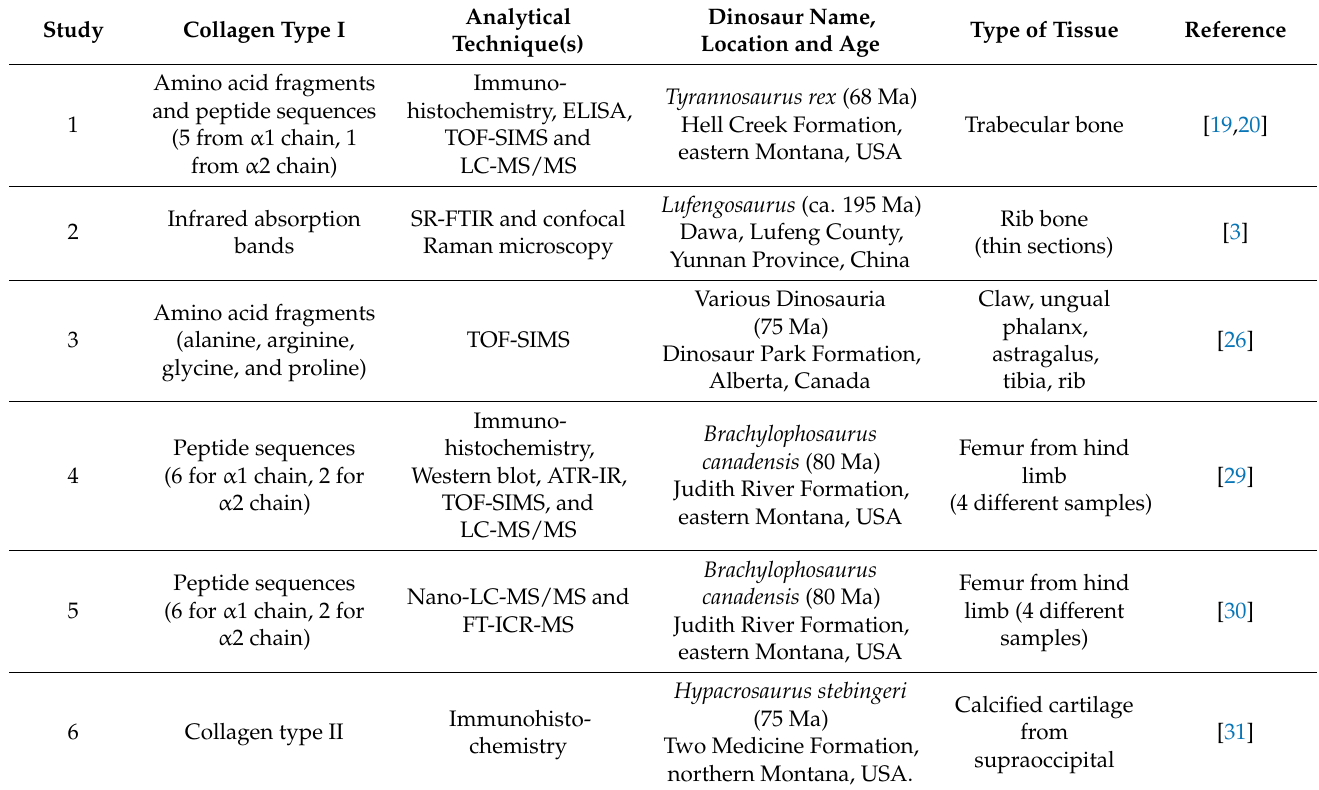
Table 3. Collagen type I and II in the dinosaur fossil